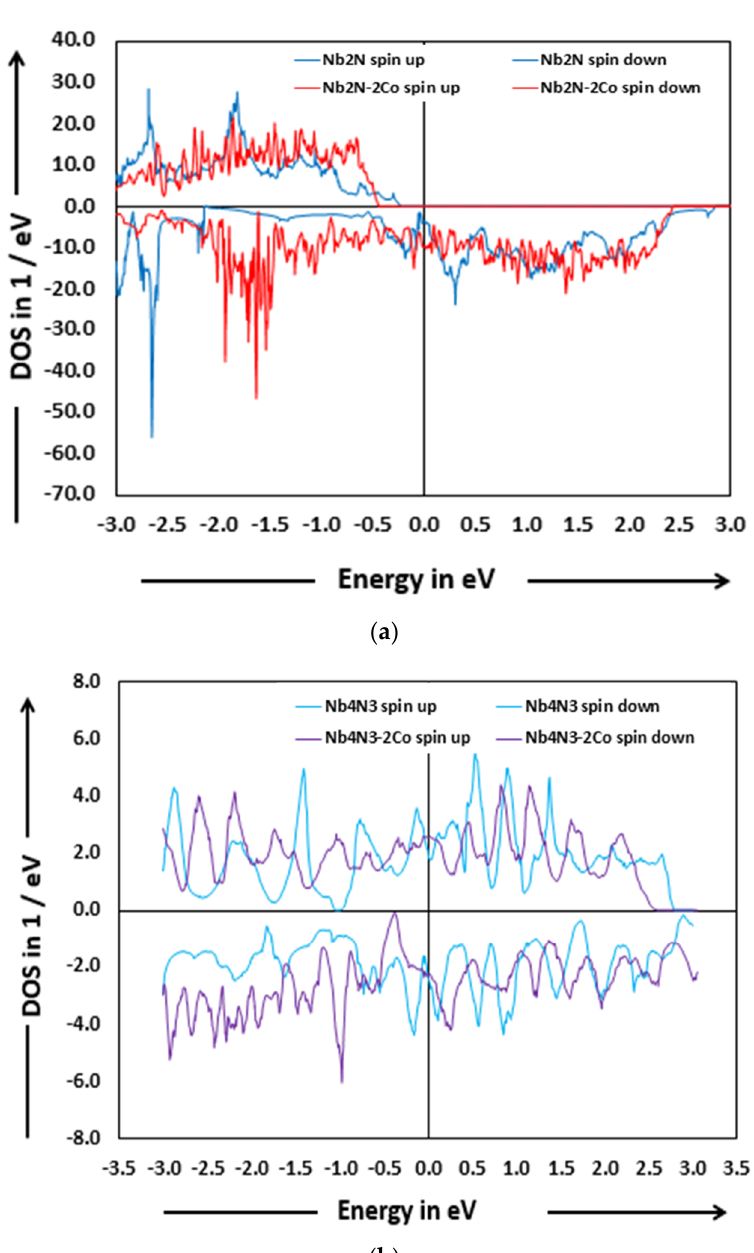
Figure 8. Comparison of the density of states of spin polarized ( a ) Nb 2 N and Nb 2 N-2Co and ( b )Nb 4 N 3 and Nb 4 N 3 -2Co.